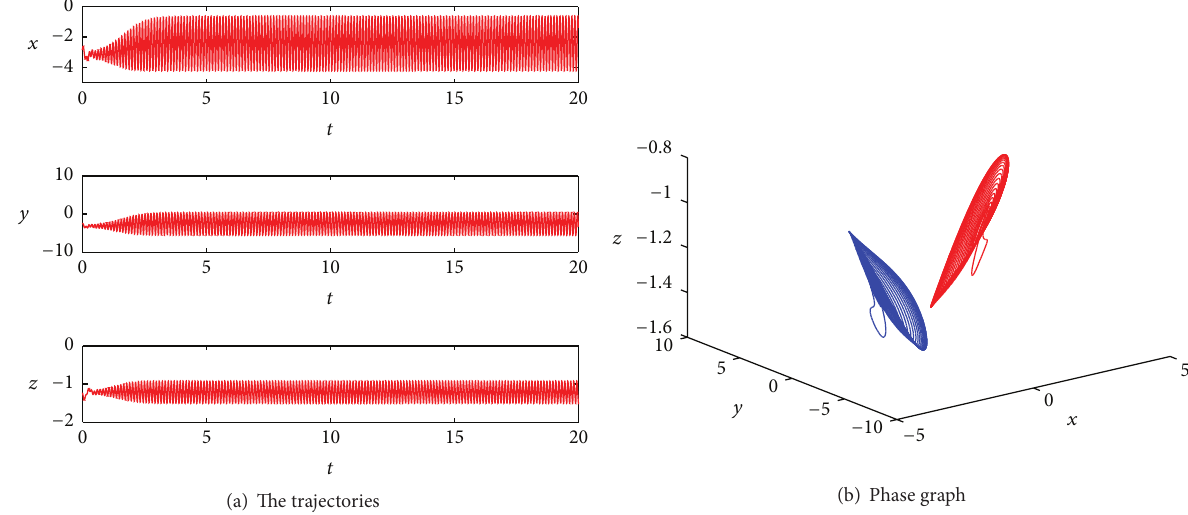
Figure 6: The trajectories and phase graphs of system (2) with 𝜏 = 0.09 , 𝑘 = −25 at initial values of phase graphs: 𝐸 1 (3.1, 3.1, −1.1) (𝑟𝑒𝑑) , (−3.1, −3.1, −1.1) (𝑏𝑙𝑢𝑒) 𝐸 2